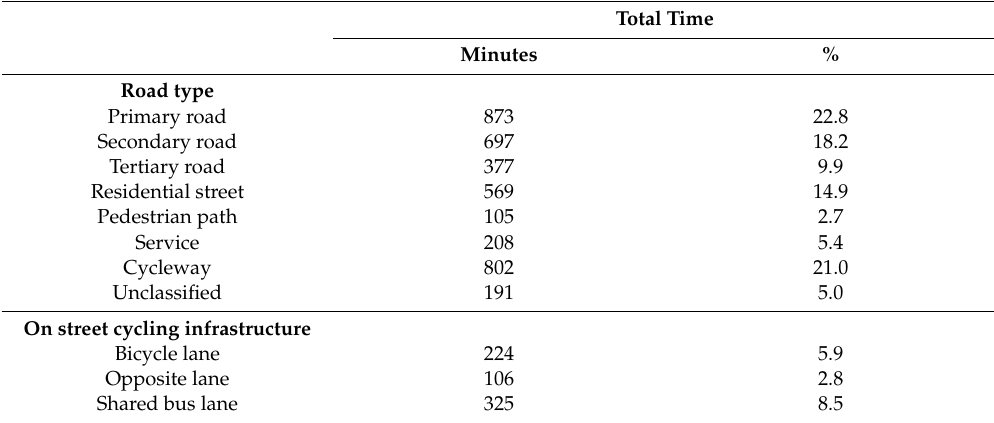
Table 3. Time spent on each type of road and cycling